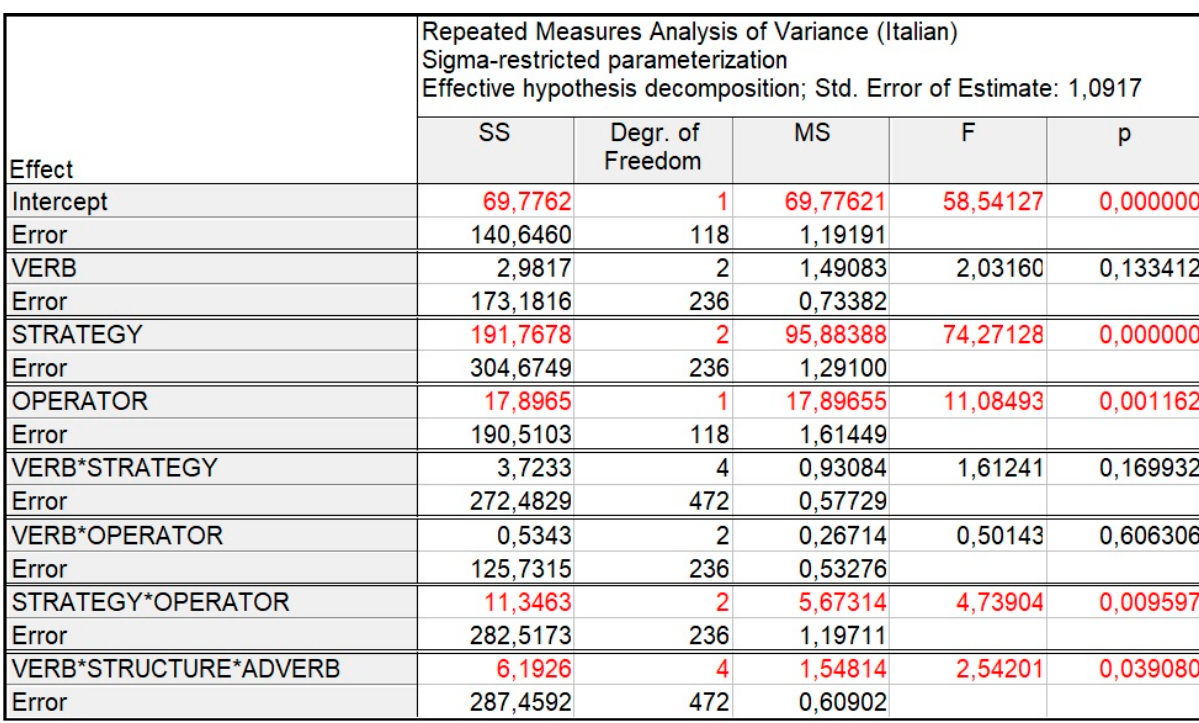
Figure 13 . Factors’ effect and their interactions (Italian) . Figure 13. Factors’ effect and their interactions (Italian).